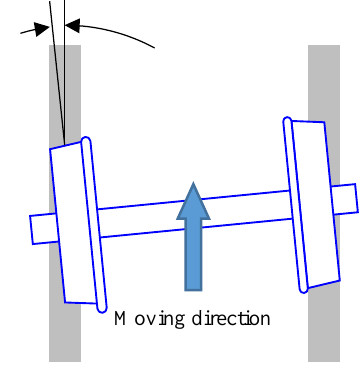
Figure 12. Attack angle diagram.